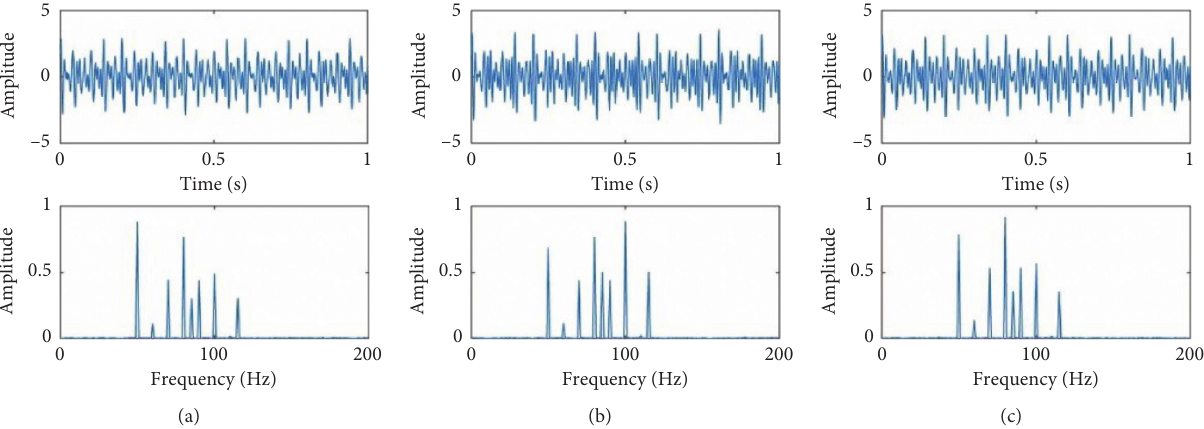
Figure 1: The time domain and frequency domain waveforms of the simulation signal. (a) Simulation signal s (c) Simulation signal s 3